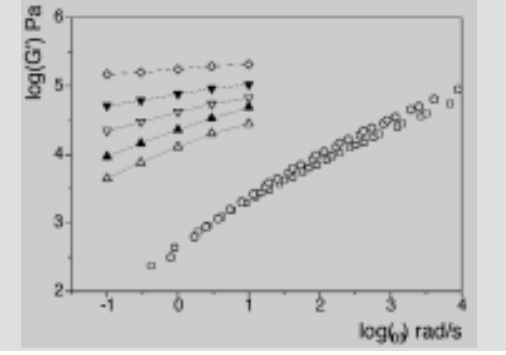
Figure 8 (left): Storage mod- ulus versus frequency at 180°C for MAH1/GMA1 50/50 blend at different reaction times tr after ther- mal equilibration and after a preshear of g R = 1000 at 105°C ( Û : tr = 0s,